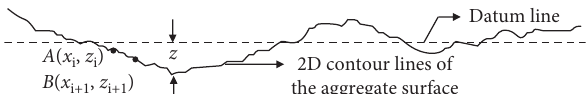
Figure 6: 2D profile of the aggregate surface.